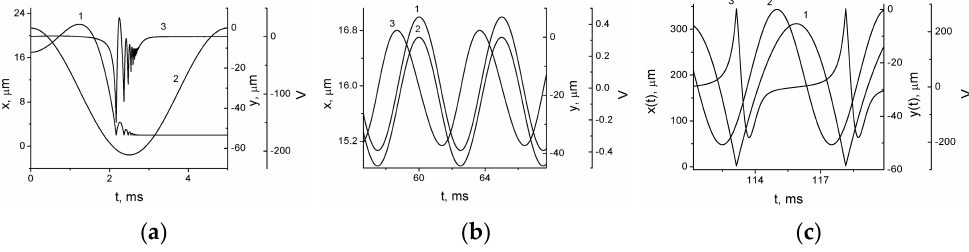
Figure 4. Kinetic curves of the excitation of electrode vibrations in the electret impact non-planar generator: ( a ) sticking mode: a = 50 m/s 2 , k = 5 × 10 4 N/m; ( b ) forced vibrations mode: a 0 = 35 m/s 2 , k = 2 × 10 5 N/m; and ( c ) impact mode: a = 40 m/s 2 . k = 2 × 10 5 N/m, R = 3 × 10 7 Ω , V P = −293 V.